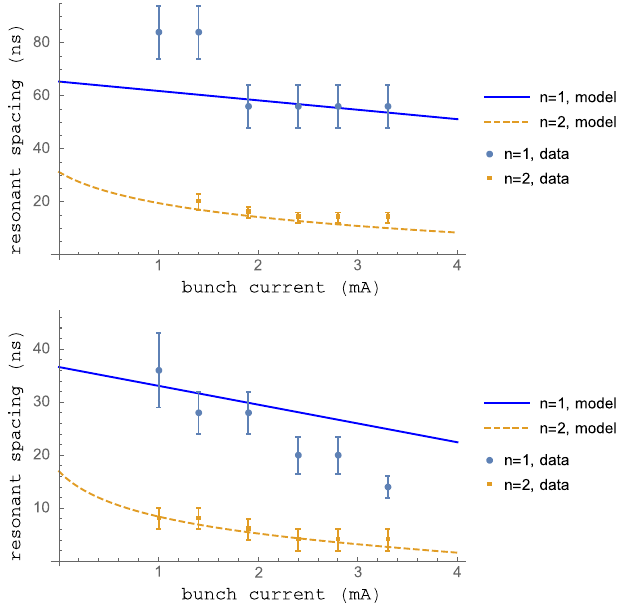
FIG. 6. Comparison of measured and predicted multipacting resonances for the chicane (top) and CESR dipole (bottom) RFAs. The solid lines represent one-bunch resonances [Eq. (5)], the dashed lines two-bunch resonances [Eq. (6)], and the points are measured data. In both cases the n ¼ 1 points are taken from the electron beam data, and the n ¼ 2 from the positron data. The error bars are defined as half the difference in bunch spacing between successive measurements.